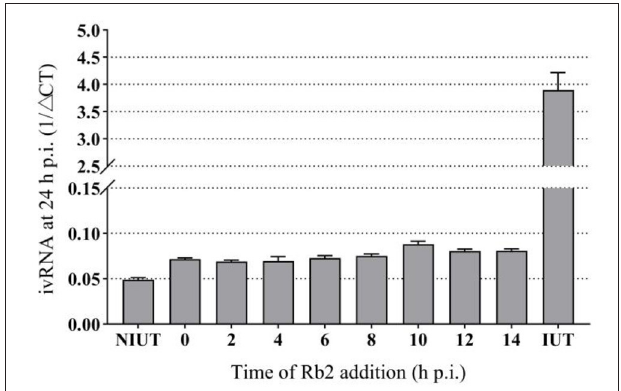
FIGURE 7 | Effect of Rb2 addition on viral RNA synthesis.